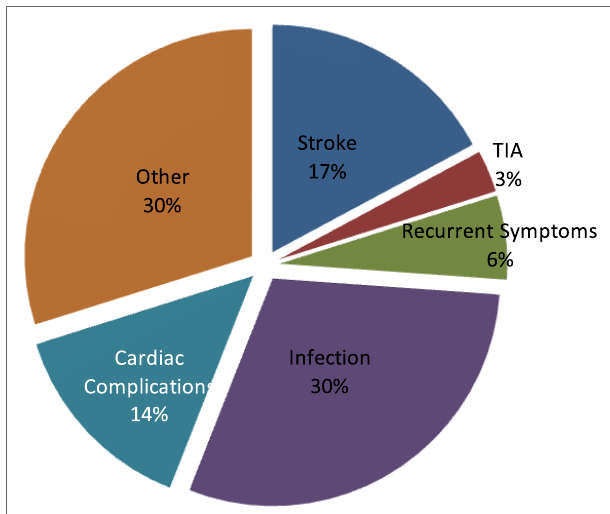
FigUre 1 | Reasons for